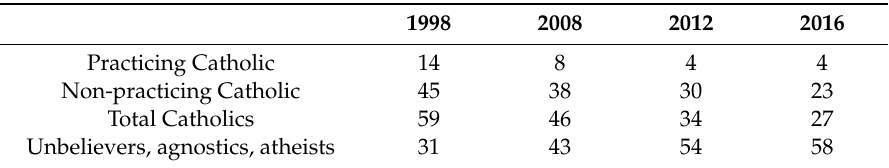
Table 2. Religious change in the BAC